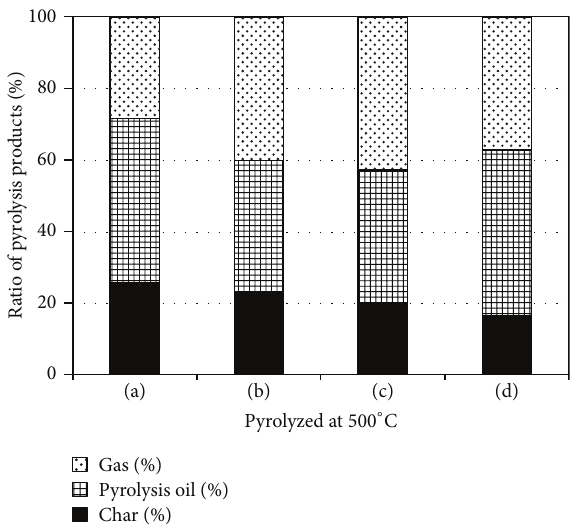
Figure 2: Product distribution of pyrolysis products obtained from Japanese cedar wood meal/catalyst (1: 1 w/w) mixtures pyrolyzed at 500 ∘ C: (a) Japanese cedar wood meal [10], (b) Wood meal/Fe 3 O 4 mixture, (c) Wood meal/TiO 2 mixture, and (d) Wood meal/ZSM-5 mixture.